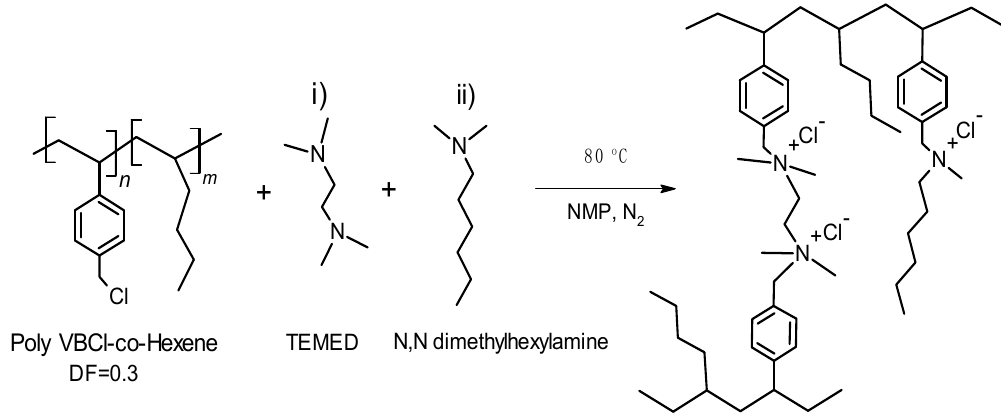
Figure 5. Pathways to synthesize the crosslinked ionomer based on poly(VBCl-co-hexene).